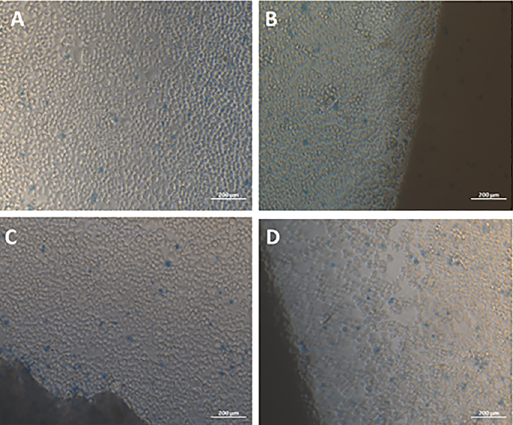
Figure 9. Macrophages culture after the seventh day. The images were obtained with magnification of 200x by an inverted microscope and corresponds to: Macrophages cultivated without the composite (A); Macrophages cultivated with the addition of pure P(HB-HV)-C specimen (B); Macrophages cultivated with the addition of P(HB- HV):ND-I specimen (C); Macrophages cultivated with the addition of P(HB-HV):ND-C (D). The dead cells are dyed blue. The shadows present in the images correspond to the